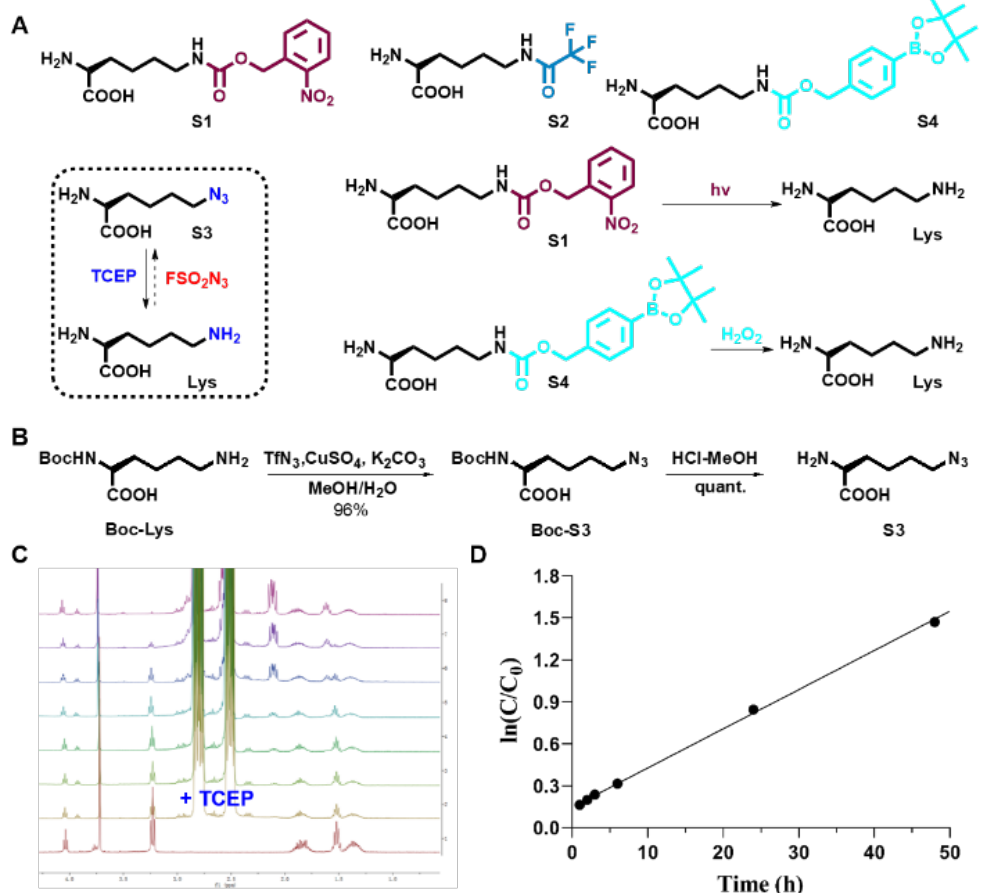
Figure 2. Investigations of lysine analogue utilizations in NSUN2 regulation studies. ( A ) Substrates (S1–S4) and their small molecule or UV-light induced reversal methods. ( B ) Synthetic details of 6-azido lysine (S3). ( C ) Illustration of Staudinger reduction of S3 with TCEP (10 eq., in D 2 O) by use of in situ proton NMR experiment. ( D ) Analysis of data for the reaction of S3 with TCEP (10 eq.). Plotting time vs ln(C/C 0 ) yields a straight line; therefore, it was identified to be a pseudo-first order dynamic where S3 (20 mM), TCEP (200 mM) in D 2 O (0.6 mL), with a slope 0.02798, and a half time t 1/2 = 24.8 min. C represents S3 concentration at a defined time, while C 0 represents initial concentration of S3. TCEP = Tris (2-carboxyethyl)-phosphine. S1–S3 are previously reported compounds, S4 is a compound recently synthesized by